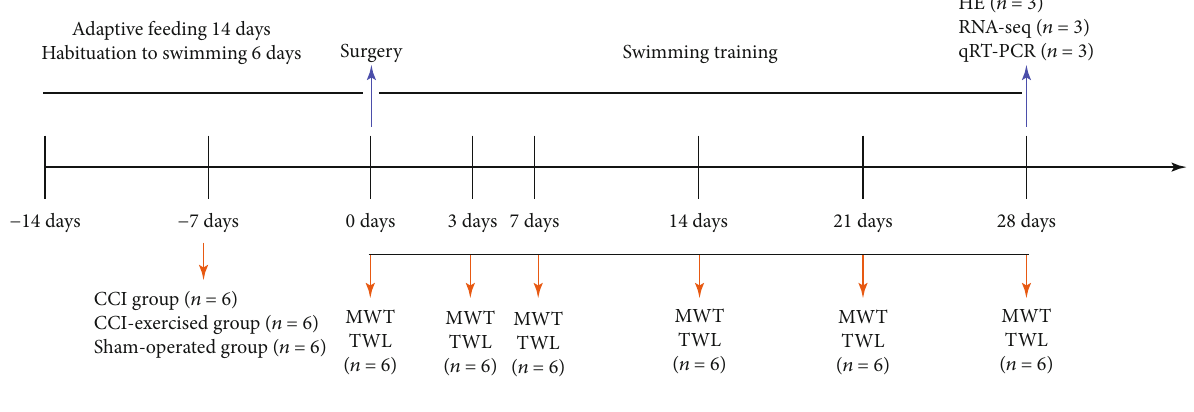
Figure 1: Experimental study design. The arrows indicate where behavioral tests were performed or samples were obtained for endpoint analysis. MWT: mechanical withdrawal threshold; TWL: thermal withdrawal latency; HE: hematoxylin-eosin staining; RNA-seq: RNA- sequencing; qRT-PCR: quantitative real-time PCR.